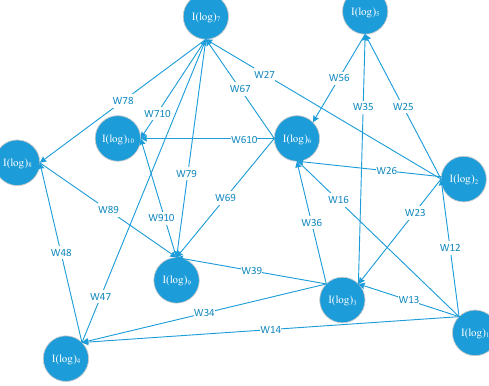
Figure 7. The weighted and directed log instances graph.